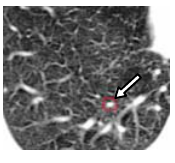
Fig. 10. The blood vessel similar to